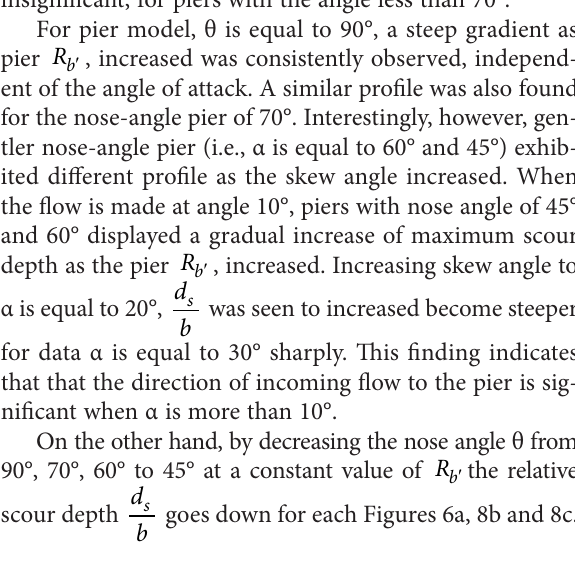
Figure 6. The relationship between relative scour depth and the projected Reynolds number of the nose-angle pier with the varying skew